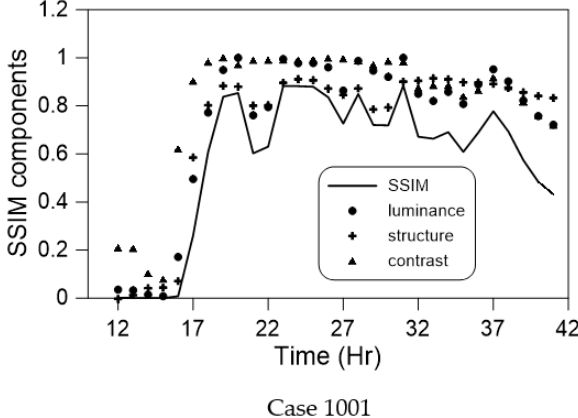
Figure 19. SSIM and its components’ variation with time in the flooding results for a rainfall event when using the Inception architecture and accumulated rainfall data containing XYZ information.